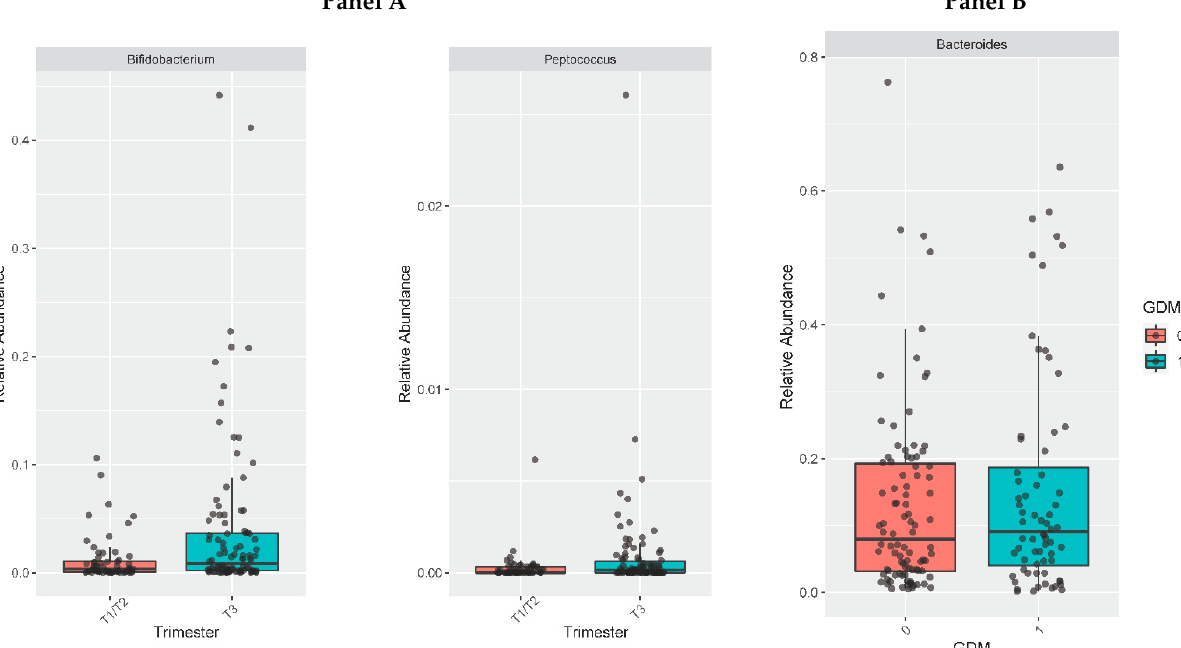
Figure 3. Abundance of selected genera according to trimester of pregnancy (panel ( A )) and presence of gestational diabetes (panel ( B )). Panel ( A ): abundance of Bifidobacterium and Peptococcus . Panel ( B ): abundance of Bacteroides .